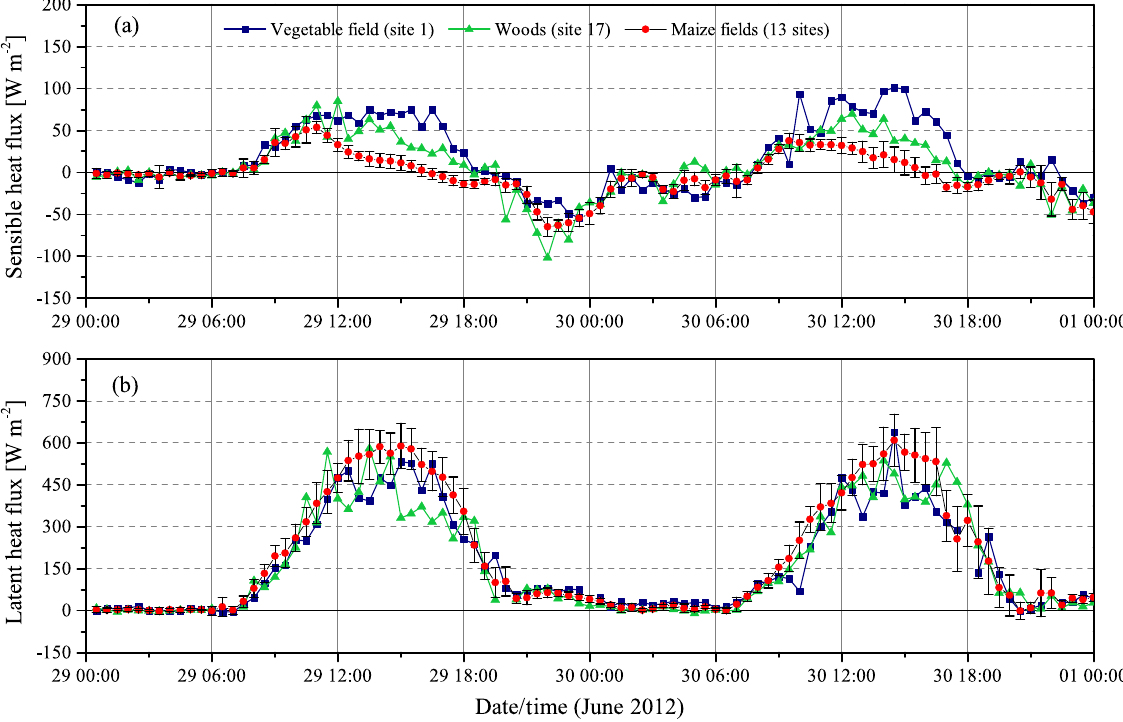
Figure 4. Diurnal cycle of the mean sensible (a) and latent (b) heat fluxes for 13 maize field sites and different types of vegetation; the error bar is the standard deviation.